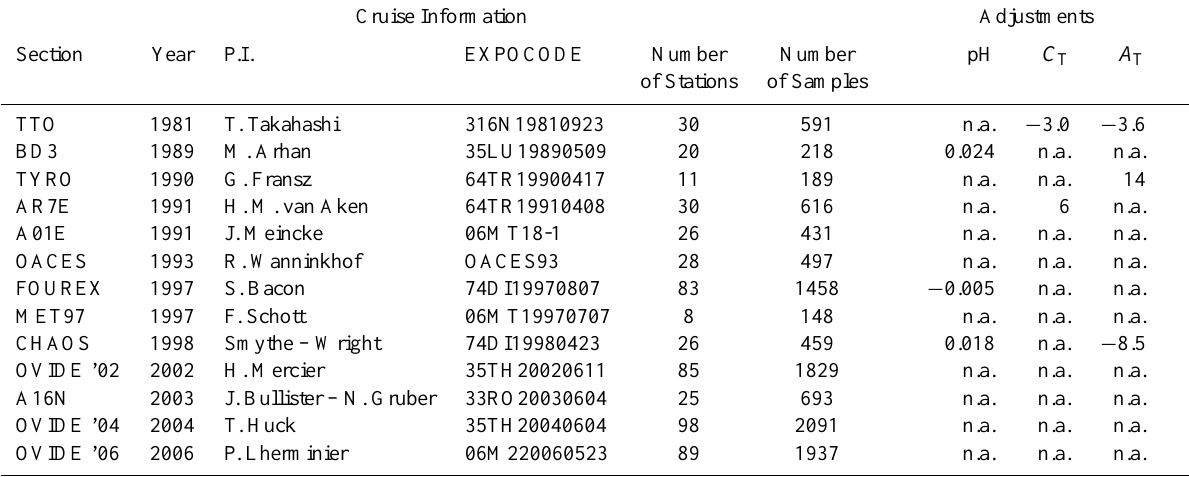
Table 1. North Atlantic cruises (Fig. 1). P.I.=Principal Investigator; n.a.=no adjustment made. The EXPOCODE is the “expedition code”, a unique alphanumeric identifier that generally has the format “ NODCYYYYMMDD ”, where NODC is NOAA’s National Oceanographic Data Center’s 4-character research vessel identifier (http://www.nodc.noaa.gov/General/NODC-Archive/platformlist.txt) and YYYYMMDD is the GMT date when the cruise left port. The FOUREX, CHAOS and OVIDE cruises reported to the CARINA database spectrophotometric pH measurements (Clayton and Byrne, 1993) in the total scale (pH T ) , while the BD3 did it in SWS scale (pH SWS ) . The adjustments from pertinent a posteriori crossover analysis (Pierrot et al., 2010; Velo et al., 2009a, b) are given in µmolkg − 1 for C T and A T and in pH units for